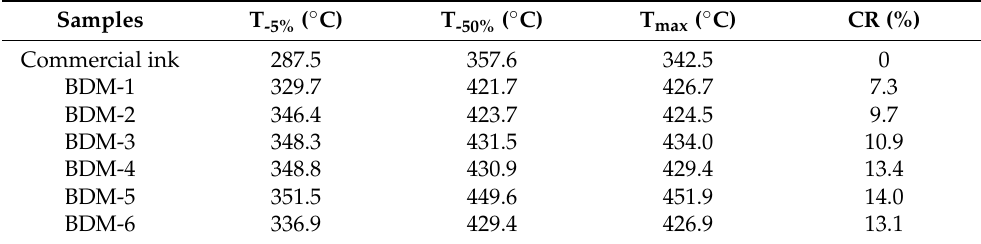
Table 5. TGA data of samples 3D-printed with commercial and BDM inks.